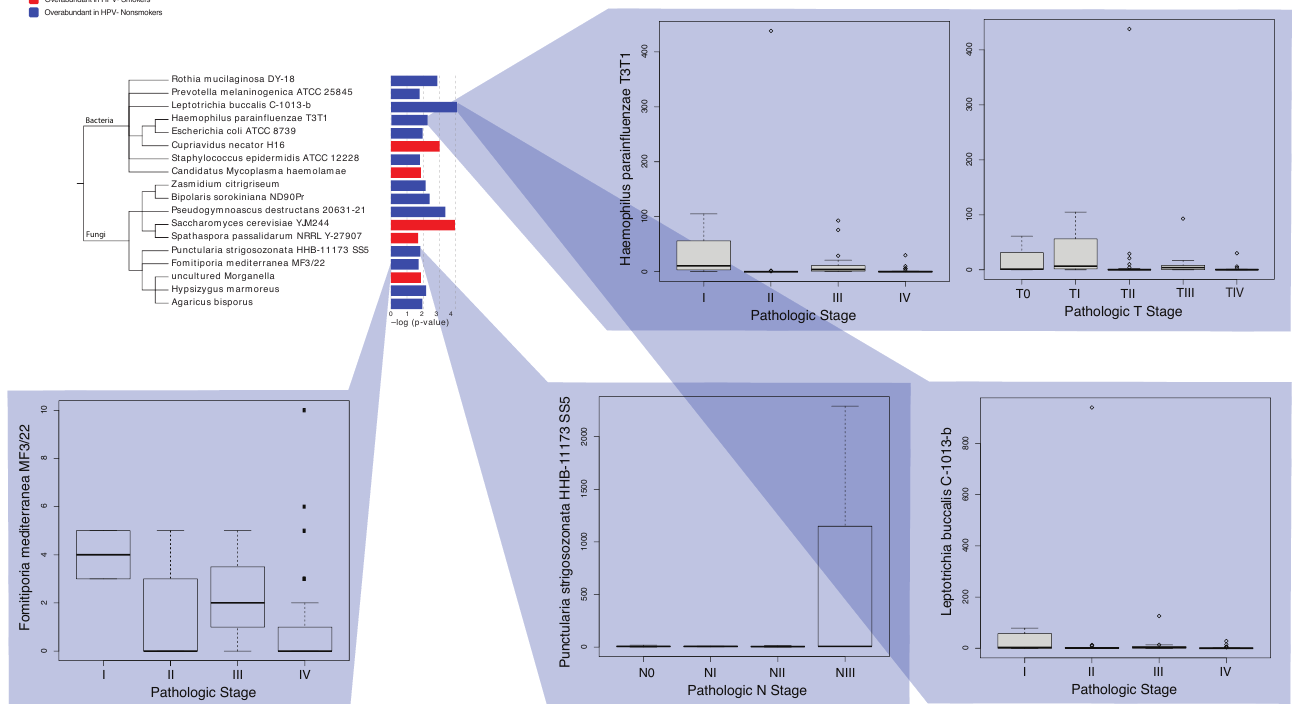
Figure 5. Clinical significance of microbes associated with HPV- smoking and HPV- nonsmoking cohorts. Significantly dysregulated microbes associated with HPV- smoking samples and HPV- nonsmoking samples are displayed with their associations with clinical variables. Red corresponds to overabundance in HPV- smokers, while blue corresponds to overabundance in HPV- nonsmokers. The Kruskal–Wallis test in the edge-R library was used to conduct clinical variable comparisons ( p -value < 0.05). In particular, we observed significant clinical variable comparisons for the following variables: pathological stage, pathological T-stage, and pathological N-stage. The trends in the plots suggest that the dysregulated microbes in HPV- nonsmokers are associated with a lower pathological stage, thus demonstrating that they may have tumor-suppressive